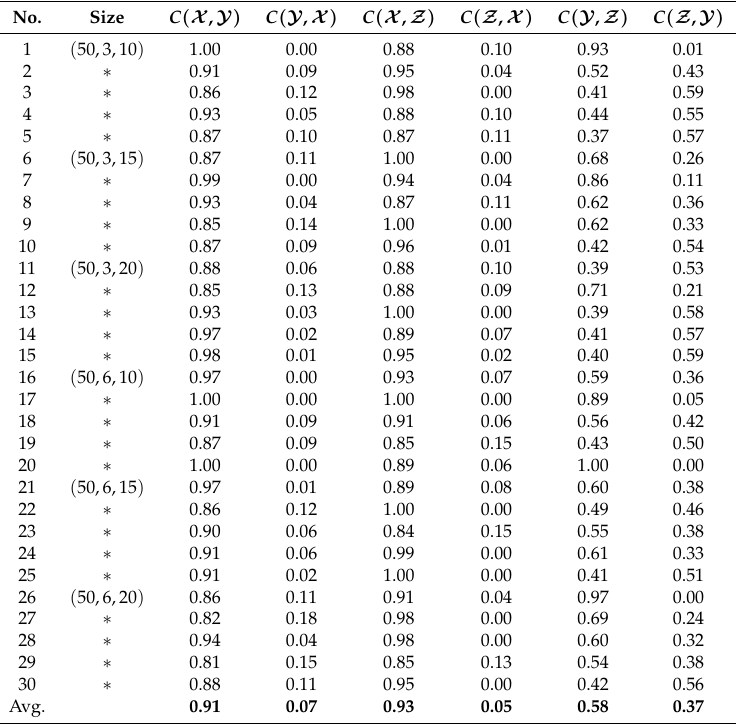
Table 8. Coverage metrics for comparing the algorithms on the test instances with 50 cars. No.